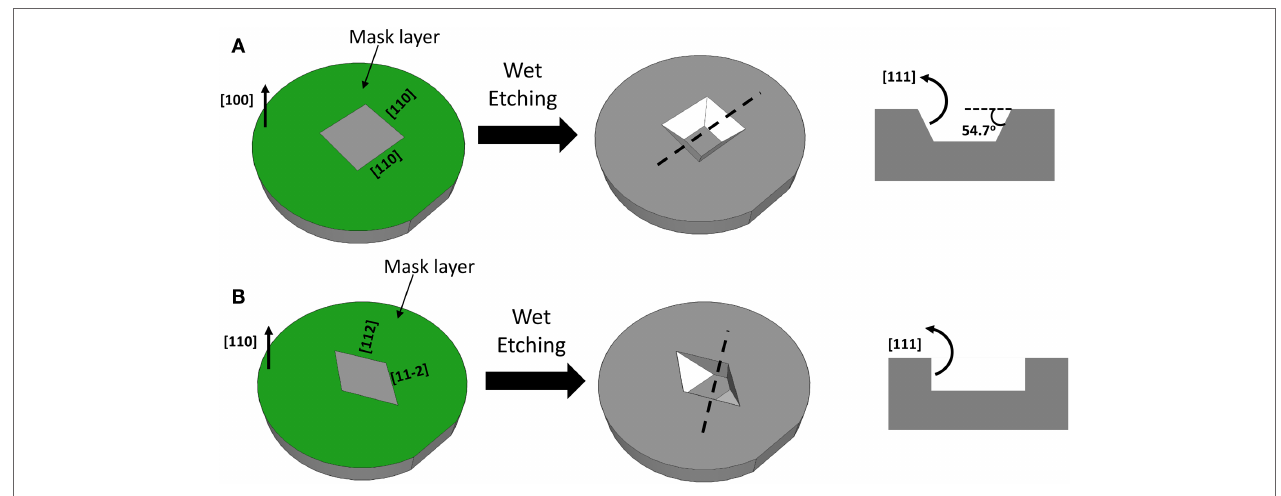
FigUre 1 | Wet anisotropically etched regions in (a) a [100]-oriented silicon substrate . The side walls are formed by stable [111] planes at an angle of 54.7° with respect to the wafer surface. (B) A [110]-oriented silicon substrate. The side walls are formed by stable [111] panes perpendicular to the wafer